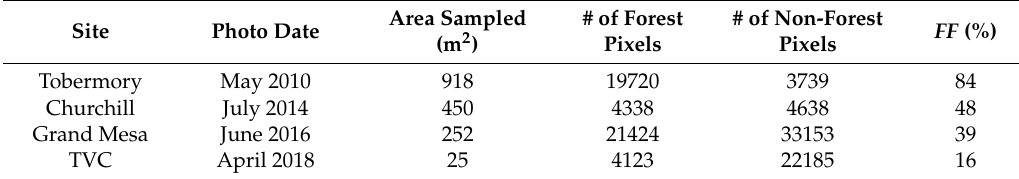
Table 4. The results of the forest cover fraction ( FF ) calculation.